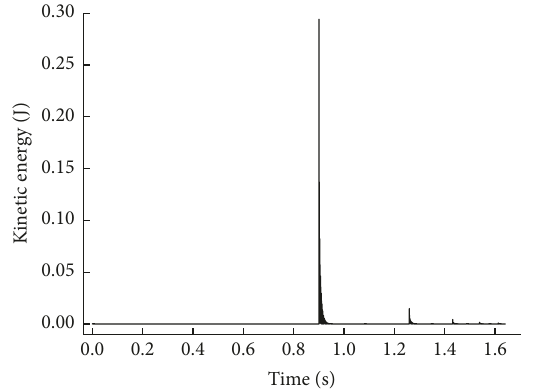
Figure 21: Kinetic energy of the metal plate.